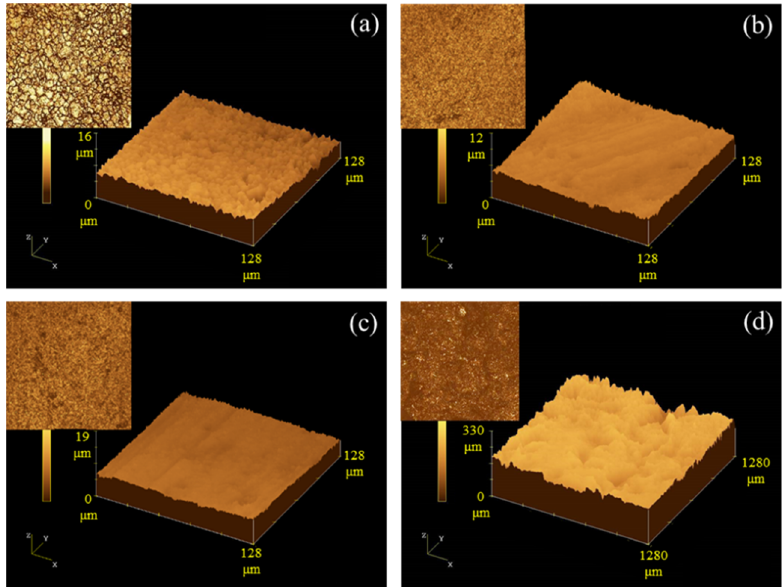
Figure 2. Laser confocal images of stainless steel after surface treatment ( a ) Acid treatment, ( b ) acid treatment + 4 μm Ni, ( c ) acid treatment + 10 μm Ni, ( d ) sandblasting + 4 μm Ni.